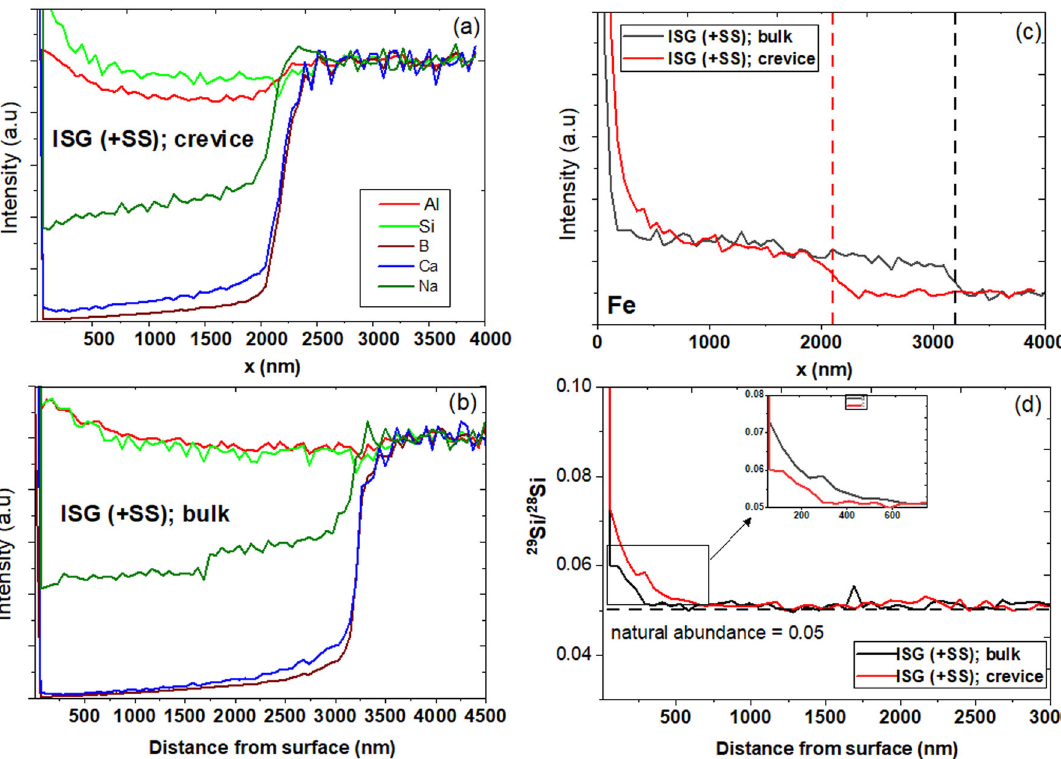
Fig. 10 ToF-SIMS elemental pro fi ling performed on ISG( + SS) in silica-saturated NaCl. a ) The depth pro fi les of glass constituents on the ISG ( + SS) creviced region. b ) corresponding data for the ISG( + SS) bulk region. c ) The depth pro fi le of Fe in both the creviced region and the bulk. The data for Cr and Ni suffer from too large noise and hence have not been reproduced here. d ) 29 Si/ 28 Si pro fi le on ISG( + SS) in both creviced region and the bulk.